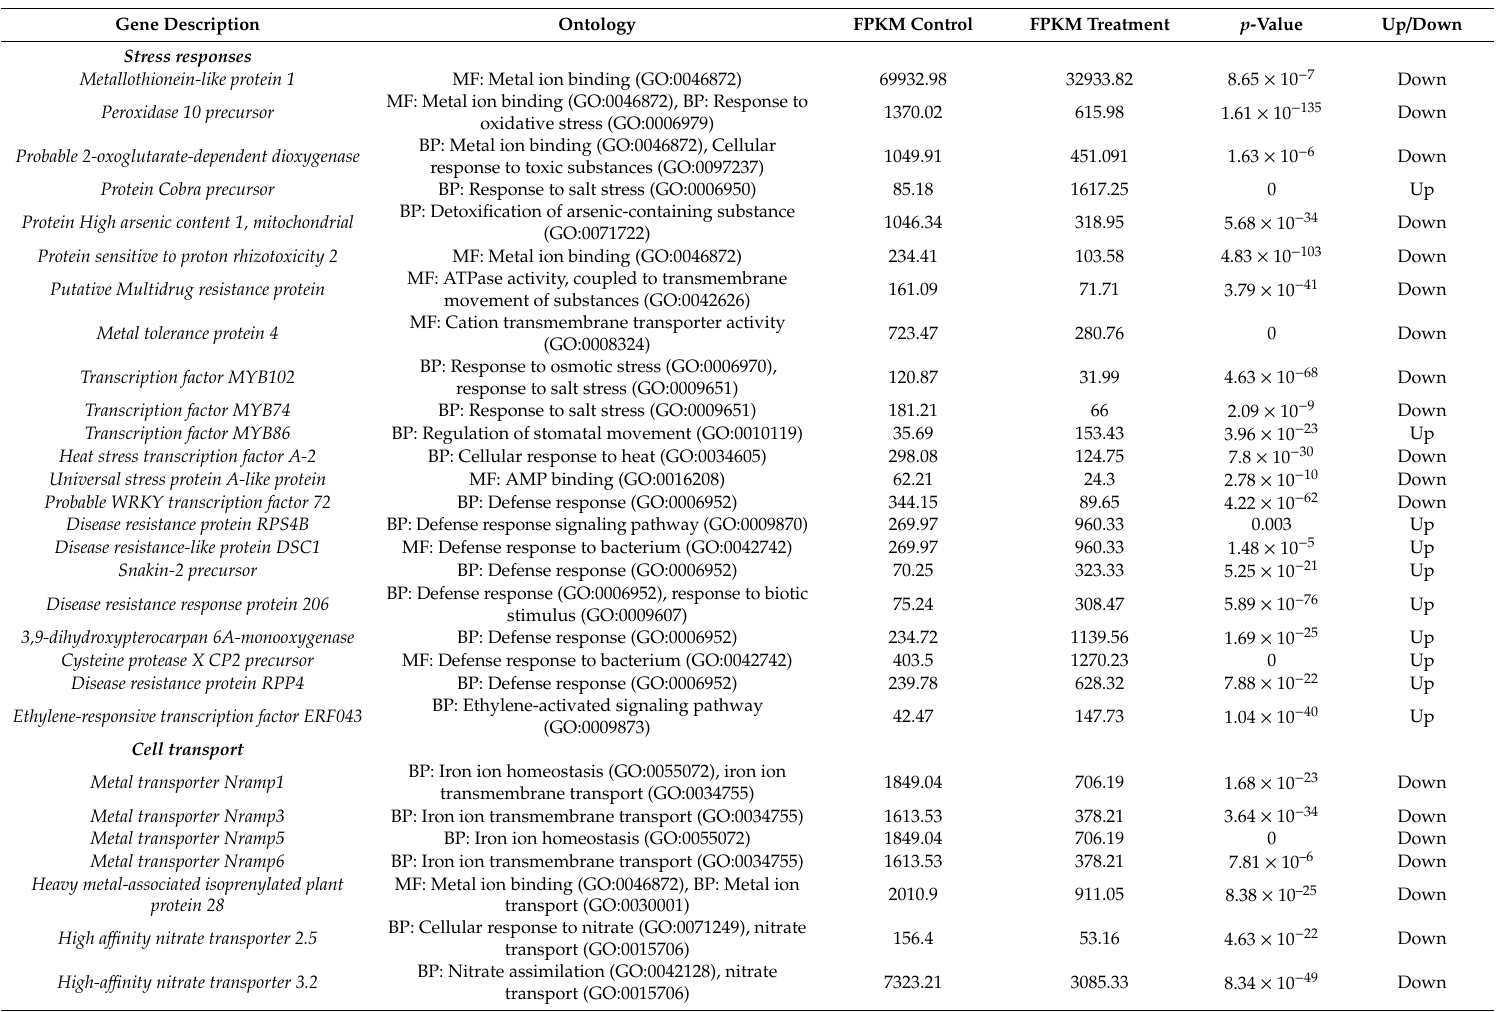
Table 3. Details of di ff erential expression genes involved in response to heavy metals stress and plant growth promotion in Eucalyptus globulus roots transcriptome. Gene